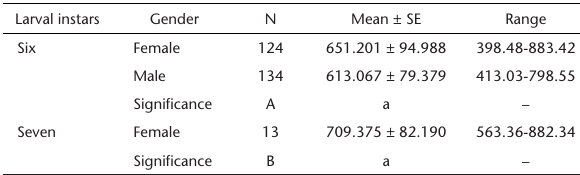
Significance level of 95%: a = p <